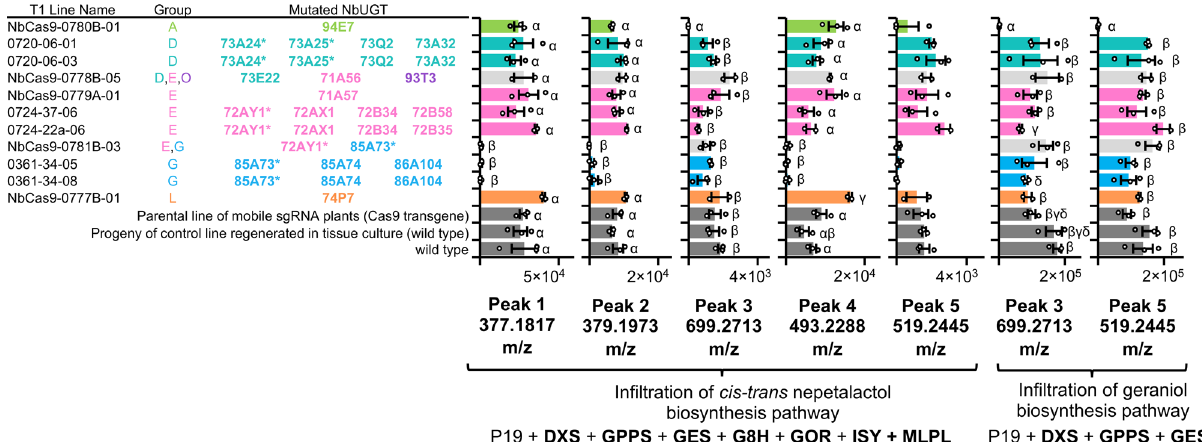
Fig. 3 Mutation of NbUGT94E7 (Group A) or NbUGT85A73 (Group G) eliminates the accumulation of speci fi c derivative compounds. The assigned identities of peaks 1-5 are provided in Fig. 1. Asterisks indicate that activity on geraniol has previously been reported. Values and error bars represent the mean and the standard error of n = 3 biological replicates. For the pairwise comparison of all mutated lines to all three control lines (gray bars), means followed by a common Greek letter ( α , β , γ , δ ) are not signi fi cantly different by a one-way ANOVA with post-hoc Tukey HSD at the 5% level of signi fi cance. Plots with no Greek letter values have no experimental lines with signi fi cant differences from the three control